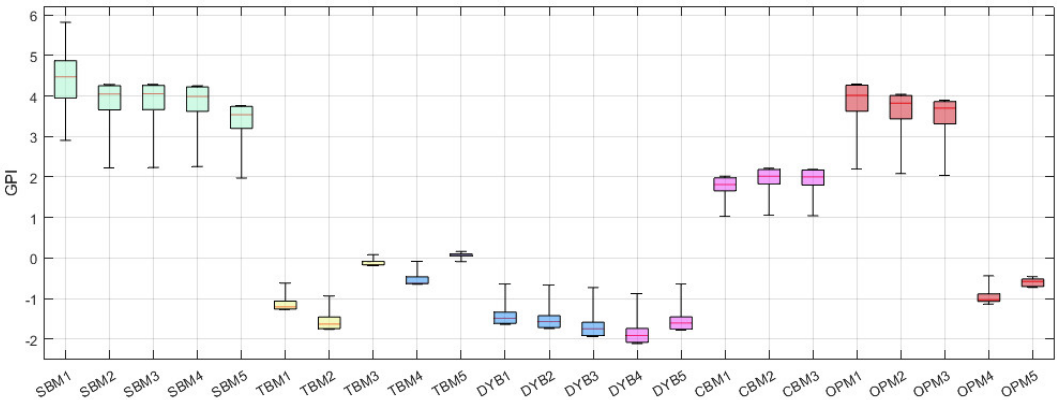
Figure 5. Distribution of GPI for each model, computed individually for each meteorological station.